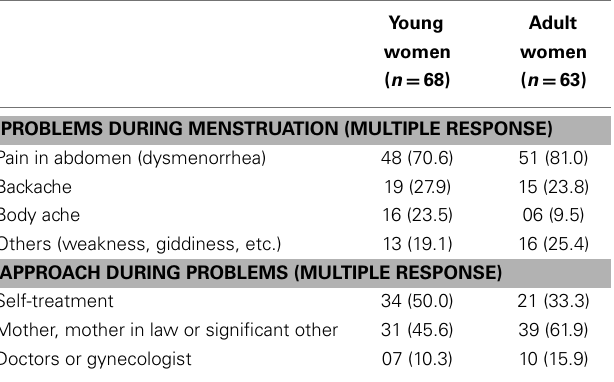
Table 4 |The complaints faced by the participants and their approach during menstruation*